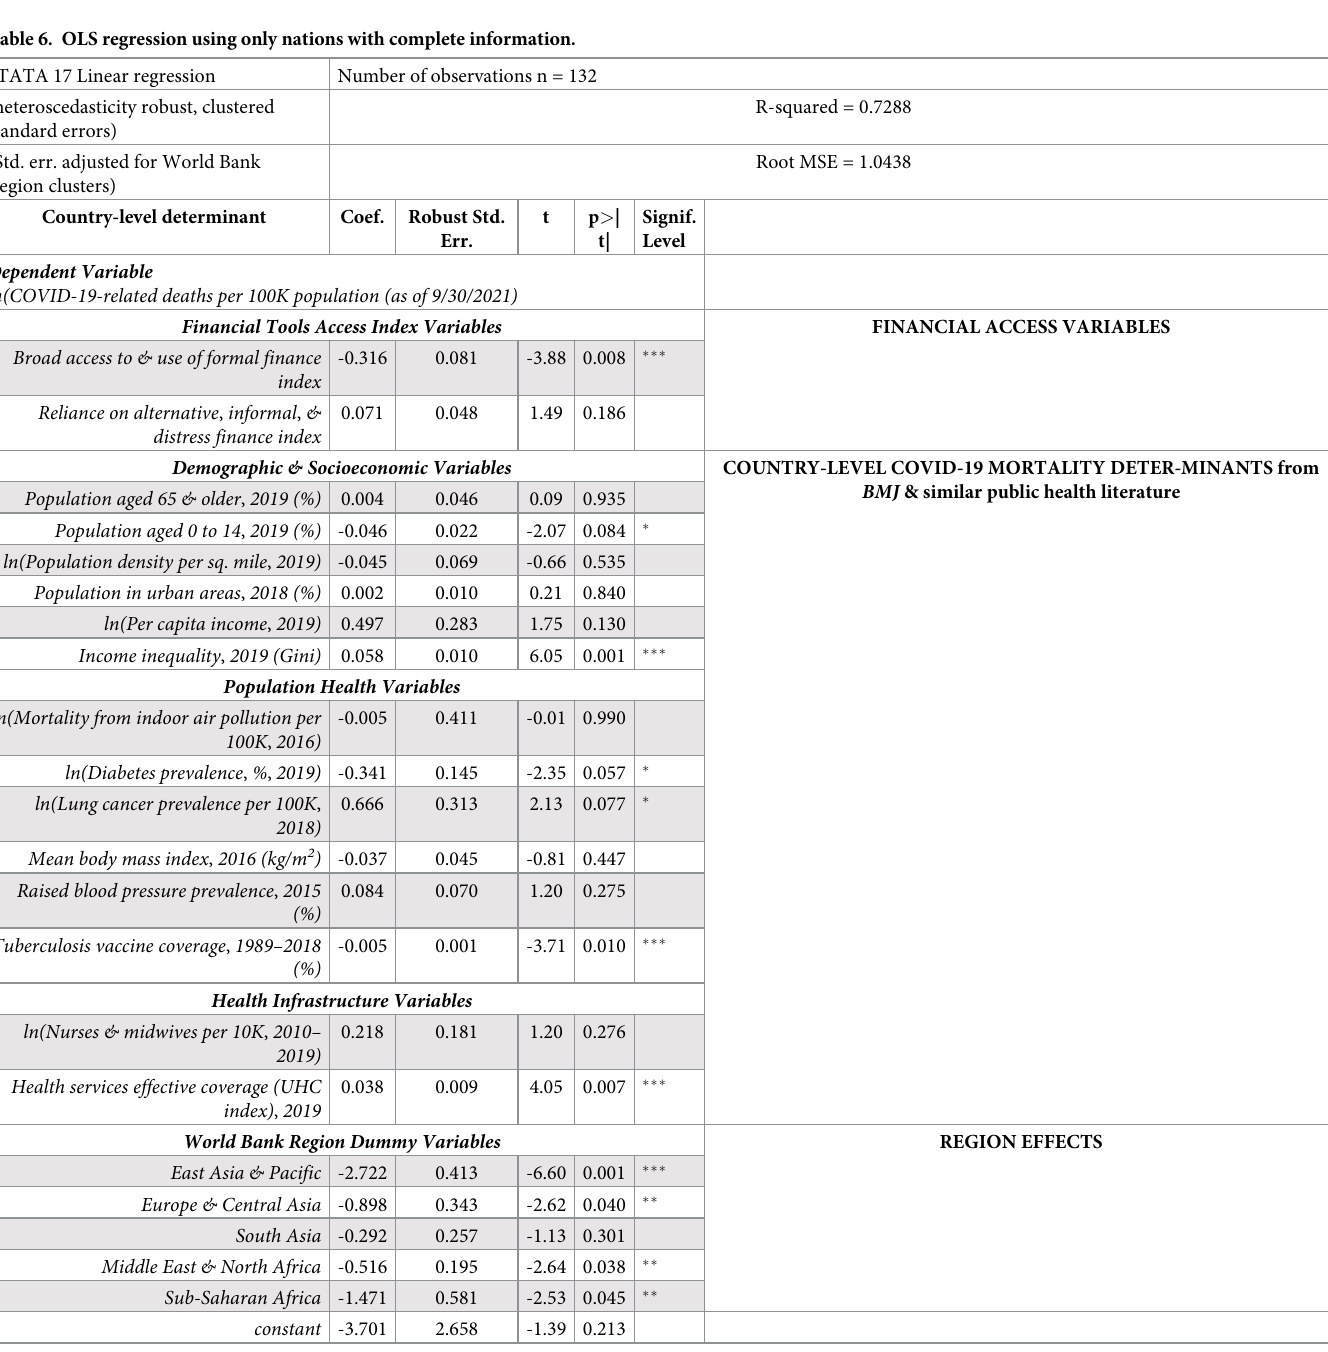
Table 6. OLS regression using only nations with complete